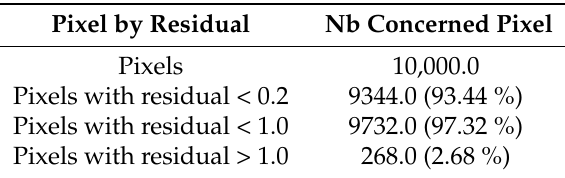
Table 3. Residuals on the full frame